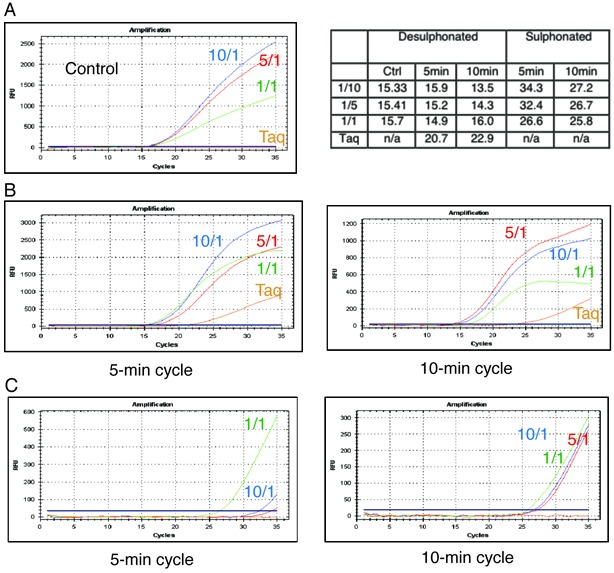
qPCR of bisulfite-treated plasmid templates. qPCR of high CG content template (0.62 kb, Figure 3 region F) using both fully desulphonated (A, B) and sulphonated templates (C) with Taq alone (orange) as well as three different 5D4/Taq blends (1/10 (blue), 1/5 (red), 1/1 (green)). qPCR Ct values for these experiment are tabulated (top right panel). (A) qPCR using standard amplification conditions. (B) qPCR of same template showing the effect of starting the PCR reaction with an extended 5 min (left panel) or 10 min (right panel) annealing/extension step. As can be seen increasing the annealing/extension time increases the ability of Taq polymerase to copy longer dU stretches. (C) Only the 5D4 blends are capable of amplifying the sulphonated templates. Interestingly, a higher 5D4 content in the blend results in an increased ability to copy the sulphonated residues as measured by real time PCR. Taq polymerase is unable to copy the sulphonated template even after a 10 min annealing/extension step.